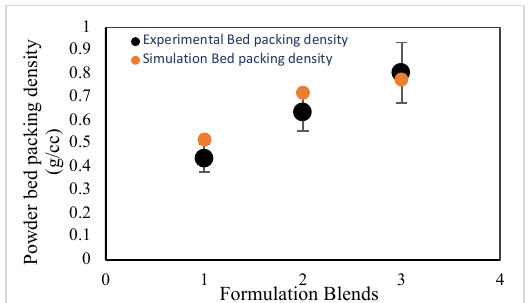
Fig. 7. Graph showing comparison of simulation and experimental